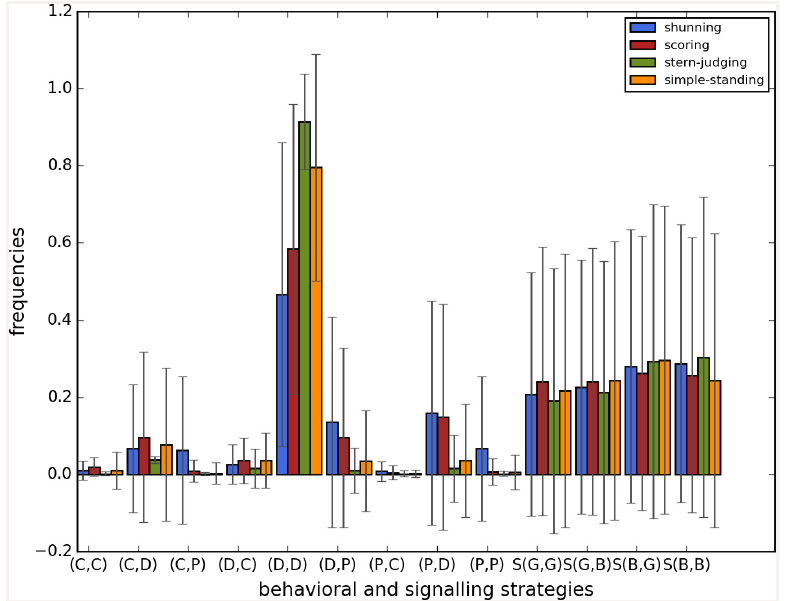
Fig 7. The frequencies of the behavioural and signalling strategies at the end of the simulations, MST80. The figure shows the frequencies of the behavioural and signalling strategies at the end of the simulations. Each bar represents the average of 100, error bars represent standard deviation, parameters are as follows: n = 100, c = 1, α = 1, β = 4, MST = 80%. The x axis shows the behavioral or signalling strategy, the y axis shows the average frequency of that strategy when runs were terminated.